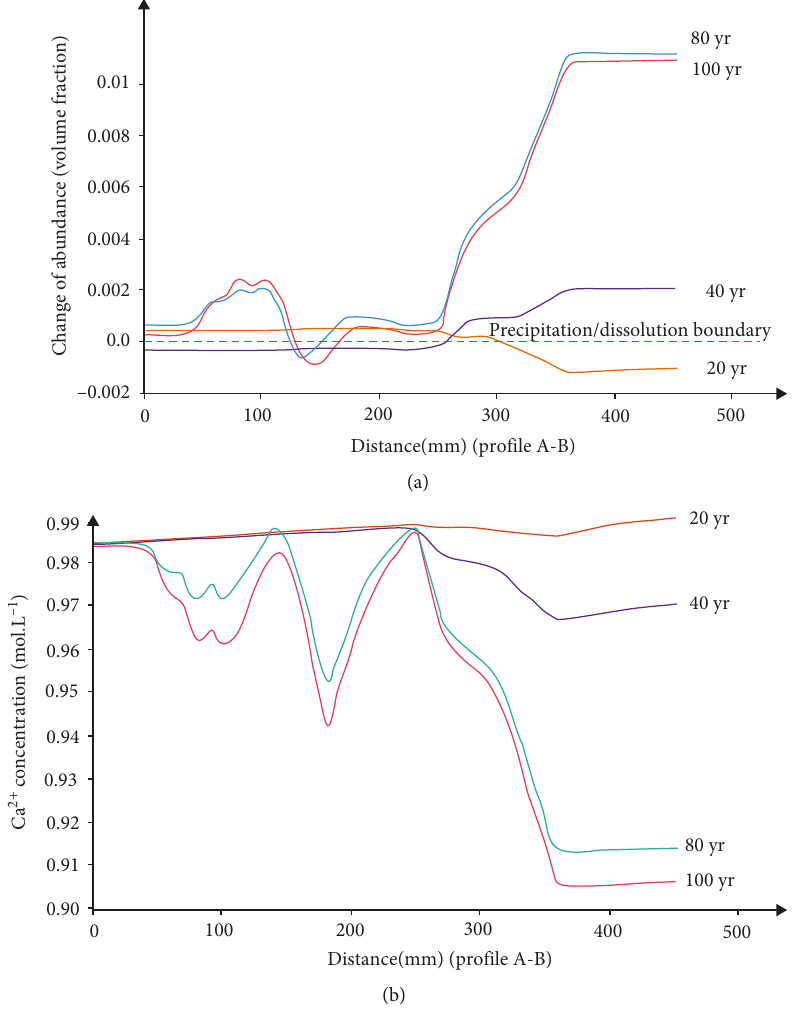
Figure 8: Spatial distribution of mineral composition varied with formation depth. (a) Changes of calcite abundance in pro fi le during fl uid injection (negative values indicate dissolution and positive precipitation); (b) changes of calcium concentration in cross section in pro fi le during fl uid